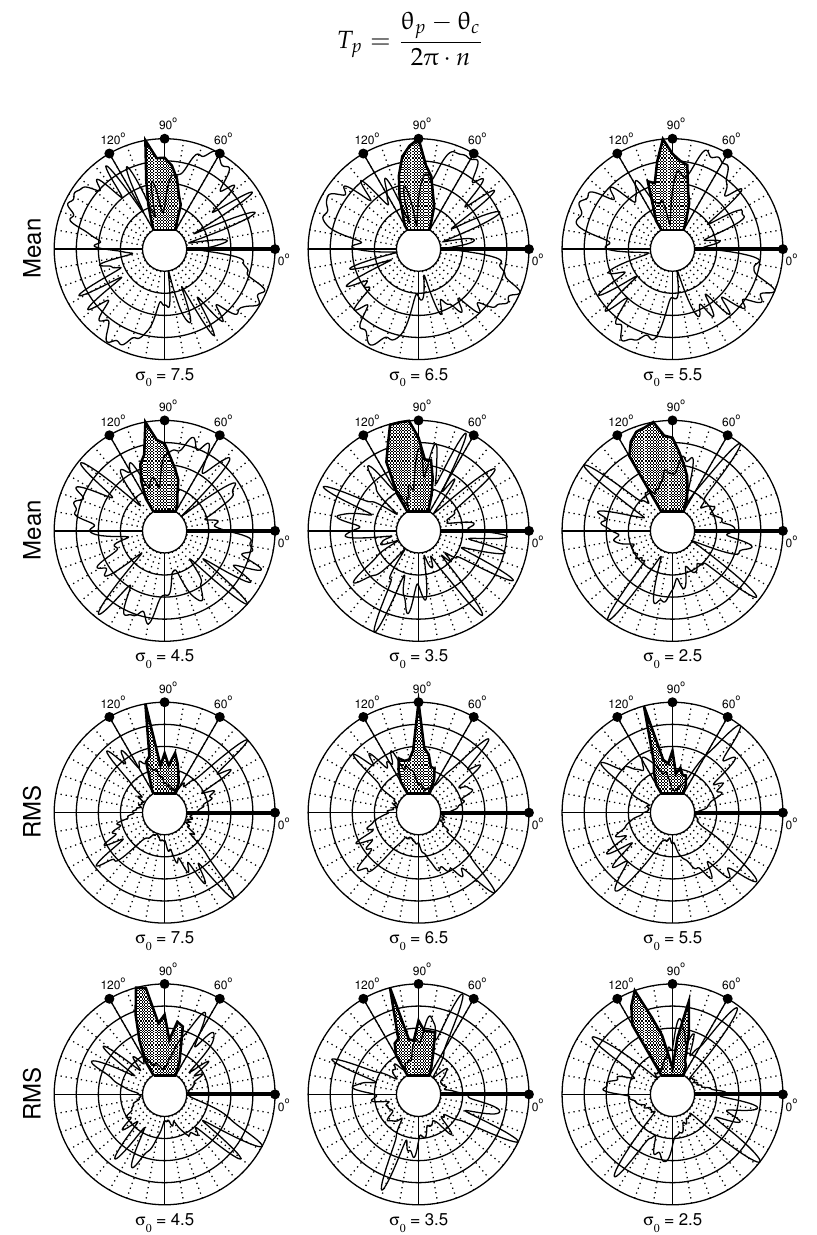
Figure 12. Angular history of pressure P 2 and cavity extension S c : mean ( top two rows ); fluctuations ( bottom two rows ). Cavitation area is represented by the grayed